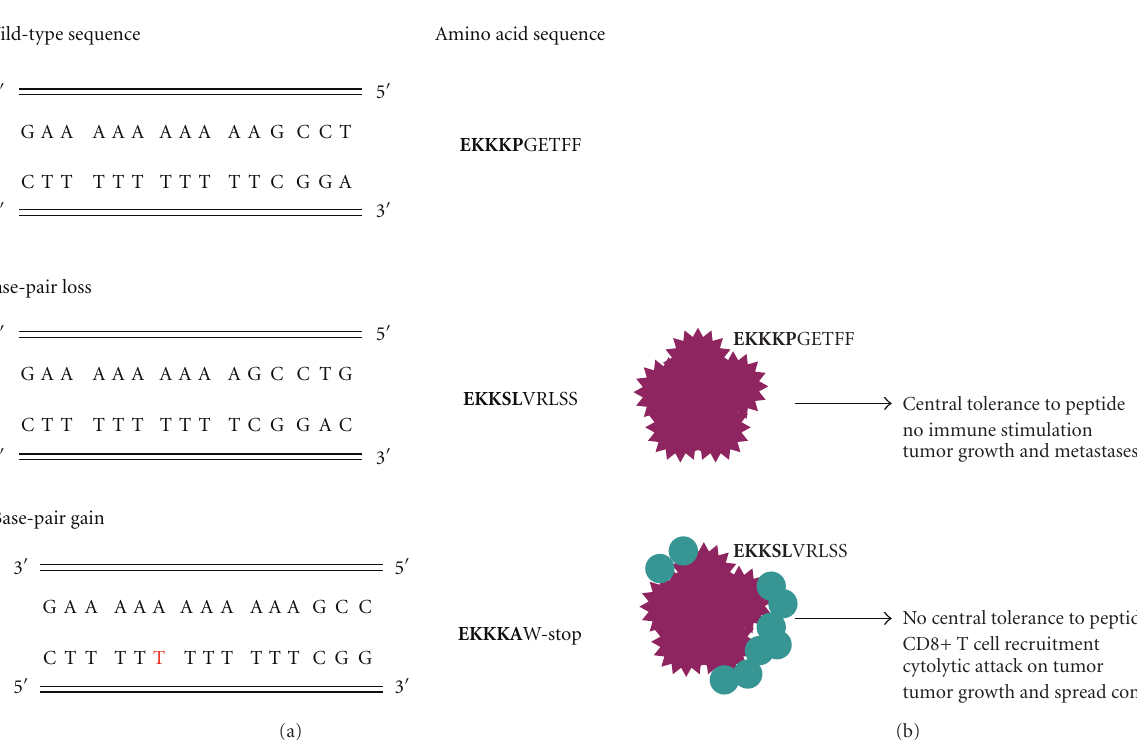
Figure 2: Defects in DNA mismatch repair genes leads to the generation of immunogenic Peptides expressed by the tumor. (a): The first sequence is a partial sequence of the TGF β RII gene. Note the ten base stretch of adenines. The area of the gene is susceptible to strand slippage during replication. When DNA mismatch repair genes are mutated, base-pairs can be lost or added during DNA replication. Additions or deletions result in an altered reading frame. Using the TGF β RII gene as an example, the amino acid sequence is shown on the right. Bolded animo acids are those amino acids represented by the nucleotide on the left. Unbolded sequences are those that are predicted based on the mutation, using the nucleotide sequence of TGF β RII (120). (b): Following the generation of novel frameshift peptides to which the immune system has not developed central tolerance to, the host can generate a robust immune response to the peptides that are uniquely expressed by the